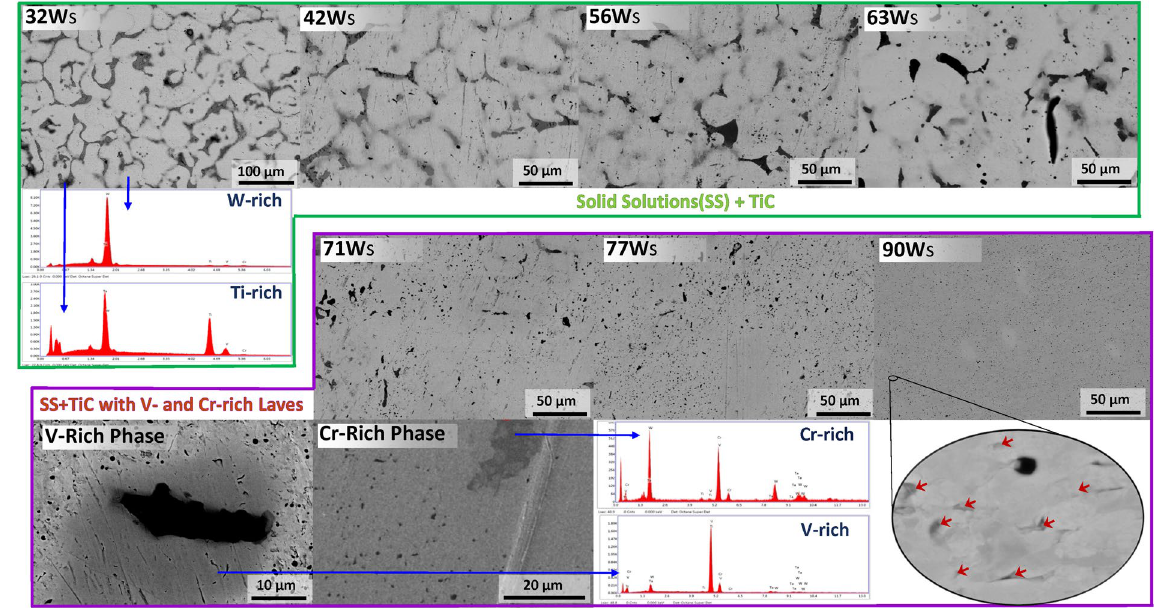
Figure 1. SEM micrographs of the xW s samples sintered at 1600 °C.